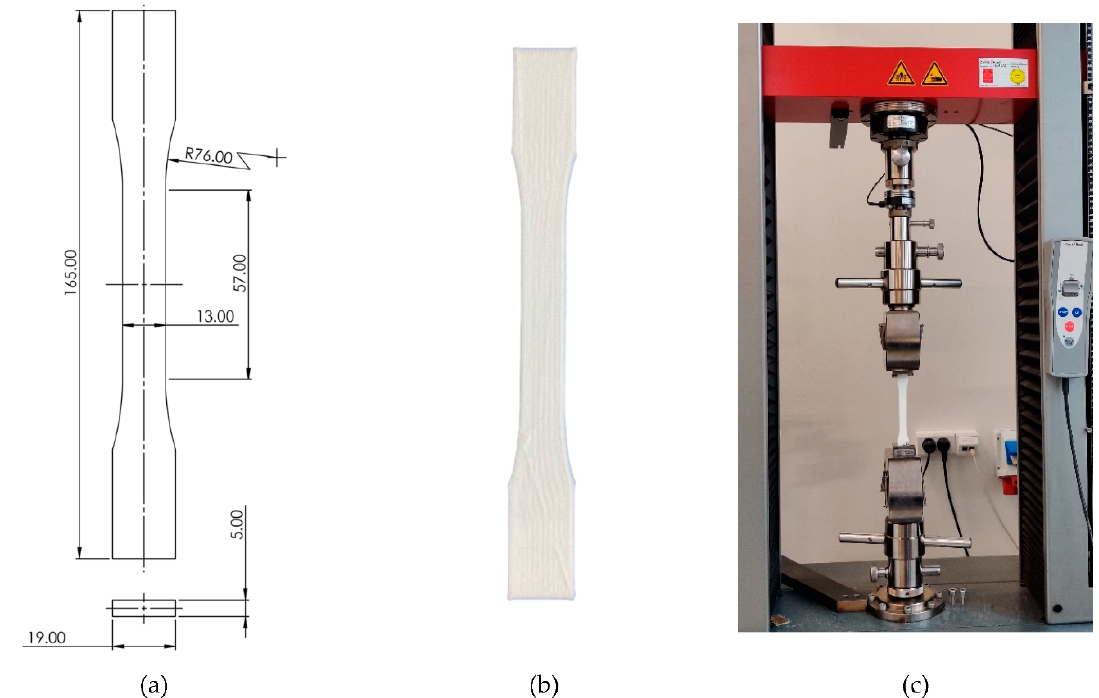
Figure 4. Uniaxial tensile test of PLA printed samples: ( a ) ASTM D638 dog-bone, ( b ) 3D printed dog-bone, ( c ) tensile testing machine.